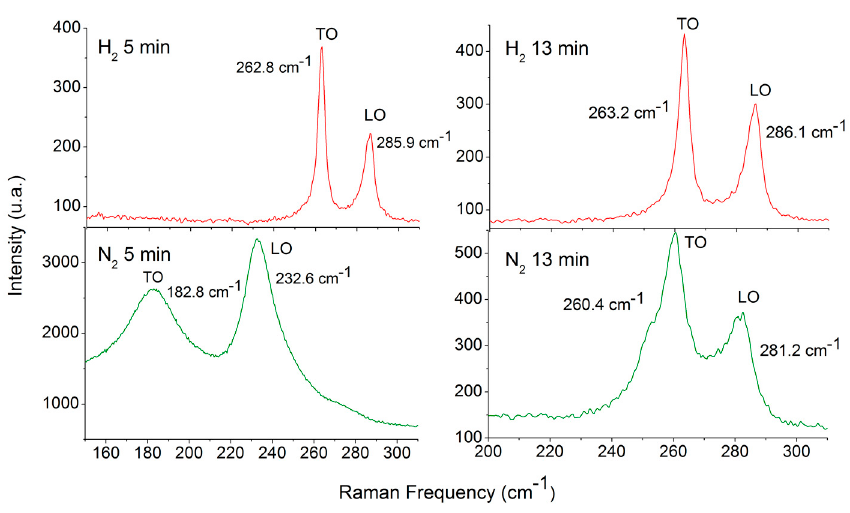
Figure 5. Raman spectra of the GaAs layers grown by CSVT technique.